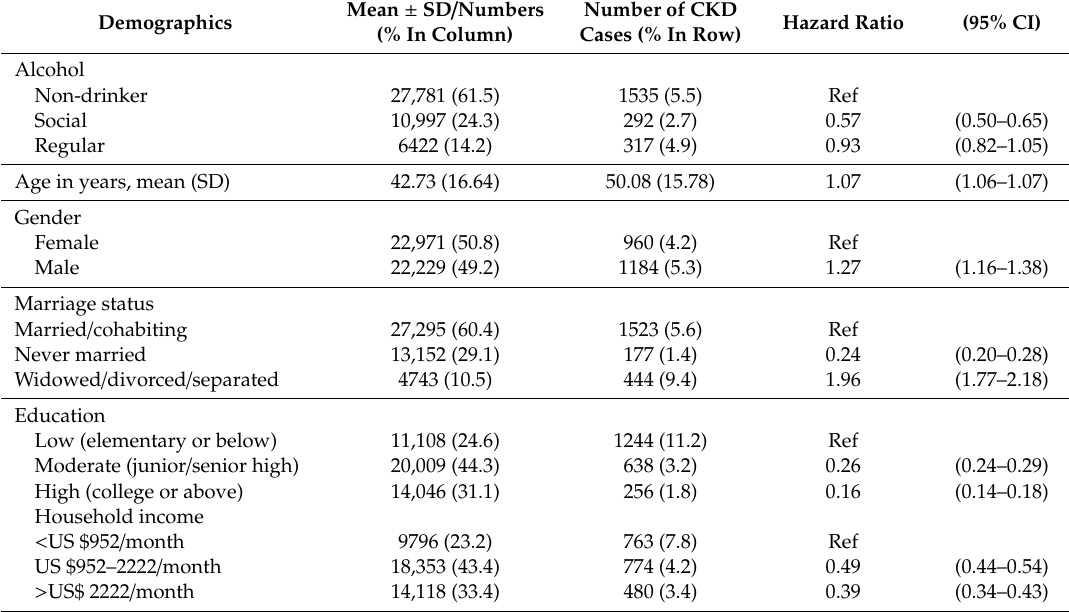
Table 1. Characteristics and results of the univariable Cox regression analysis of a random community sample in Taiwan ( n = 45,200; 2144 chronic kidney disease (CKD)